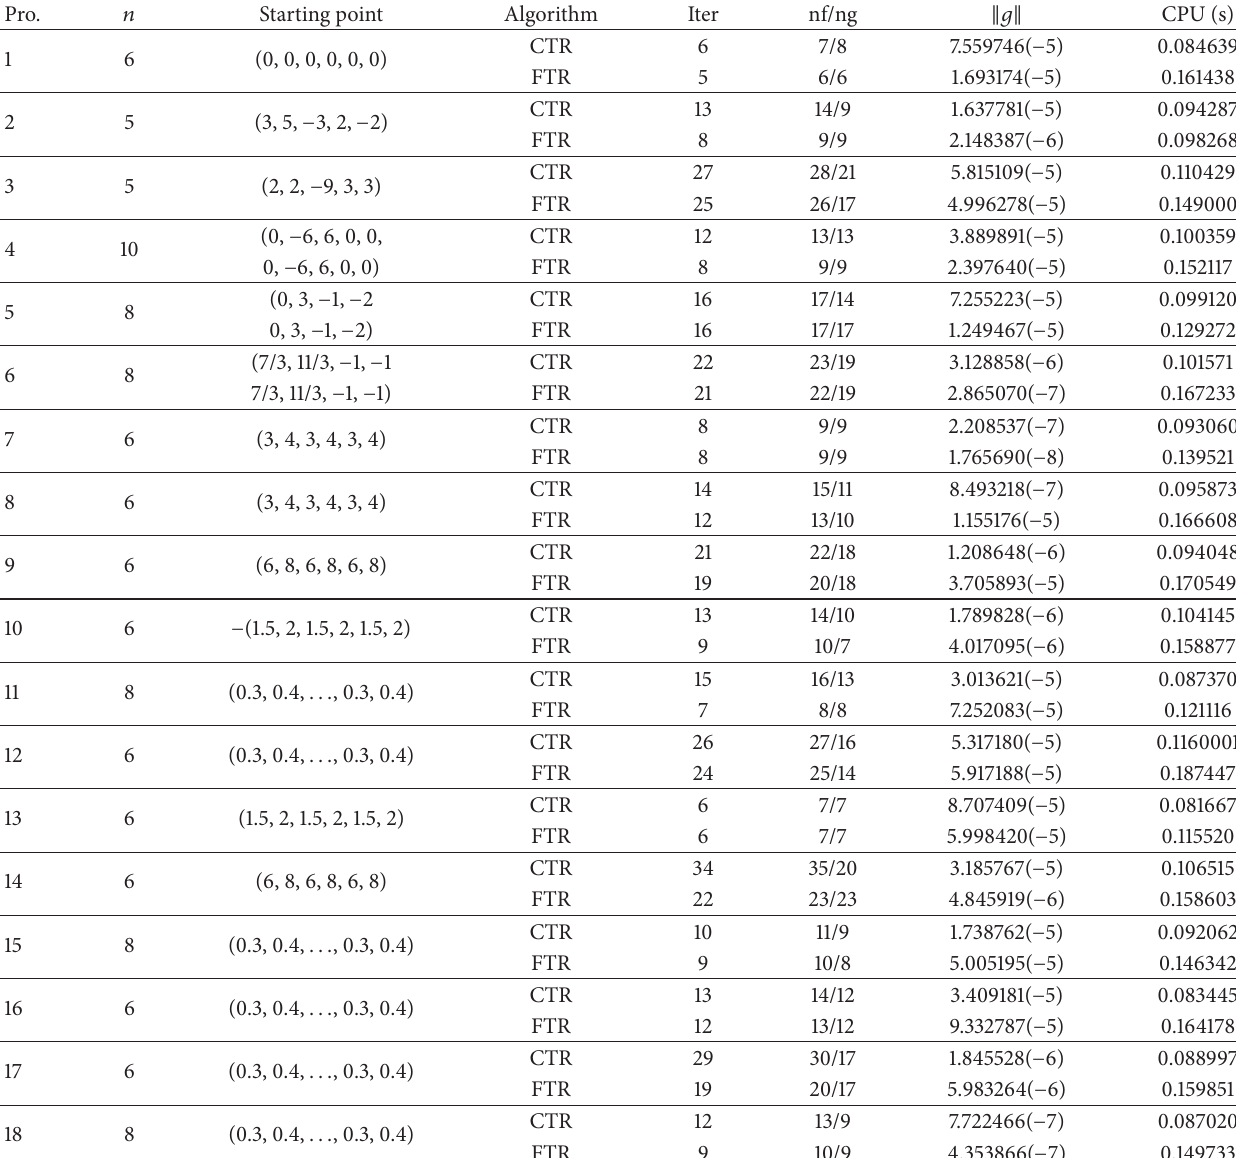
Table 2: The numerical results of Algorithm 7 for some test problems.